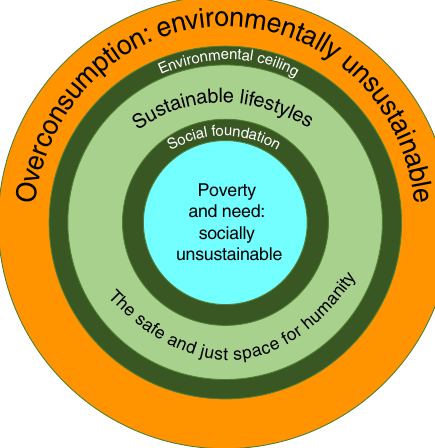
Fig. 2 The safe and just space for humanity. Sustainable lifestyles are situated between an upper limit of permissible use ( “ Environmental ceiling ” ) and a lower limit of necessary use of environmental resources ( “ Social foundation ” ) ( fi gures from ref. 49 and ref. 84 combined and